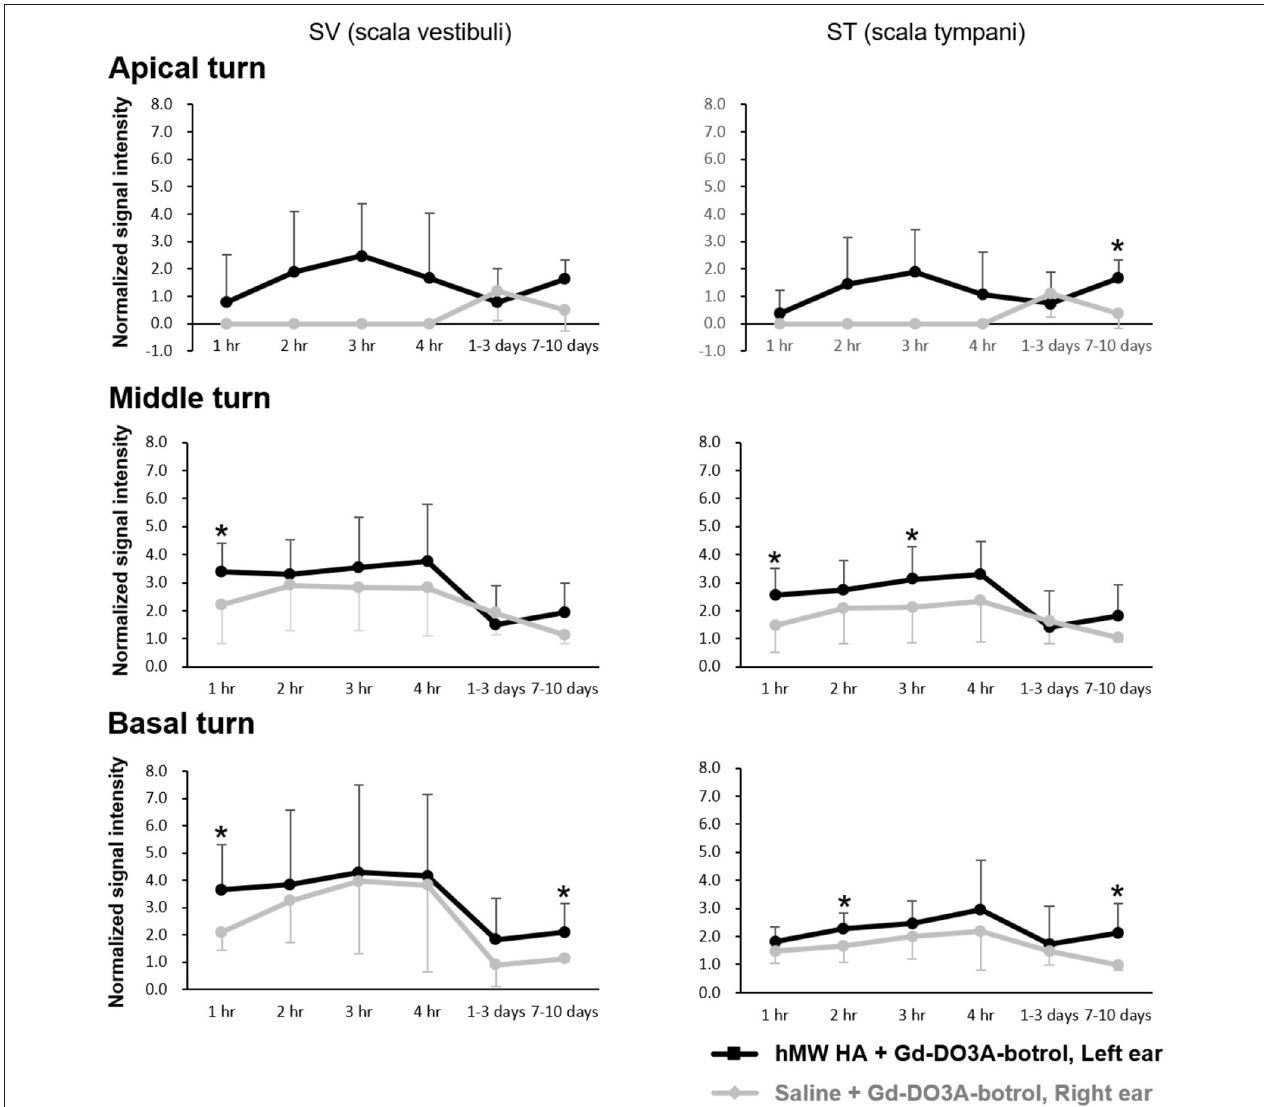
FIGURE 5 | Quantification of long-term normalized signal intensities (SIs) in the scala vestibuli (SV) and scala tympani (ST) after intratympanic (IT) gadolinium (Gd) injection with two different vehicles. The SI was higher when Gd-DO3A-butrol was delivered in a high-molecular-weight (hMW) hyaluronic acid (HA) vehicle instead of saline. This difference was most significant at 1h after IT Gd injection in the basal and middle turns. The significant elevation in SI lasted for 7–10 days after hMW HA + Gd injection in the basal (SV and ST) and apical (ST) turns. * p <